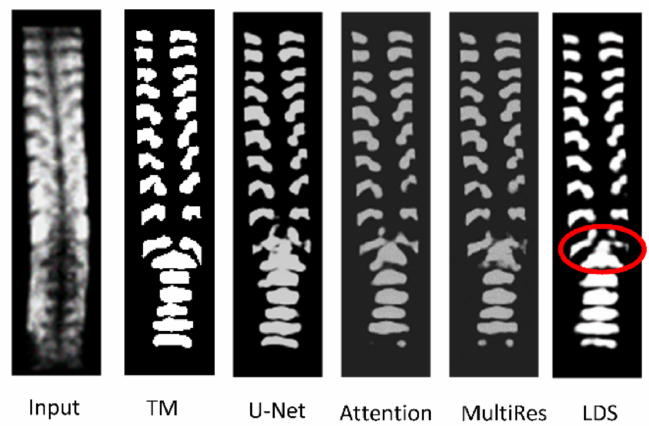
Figure 14. LDS U-Net is unable to distinguish the T12 level and 1st